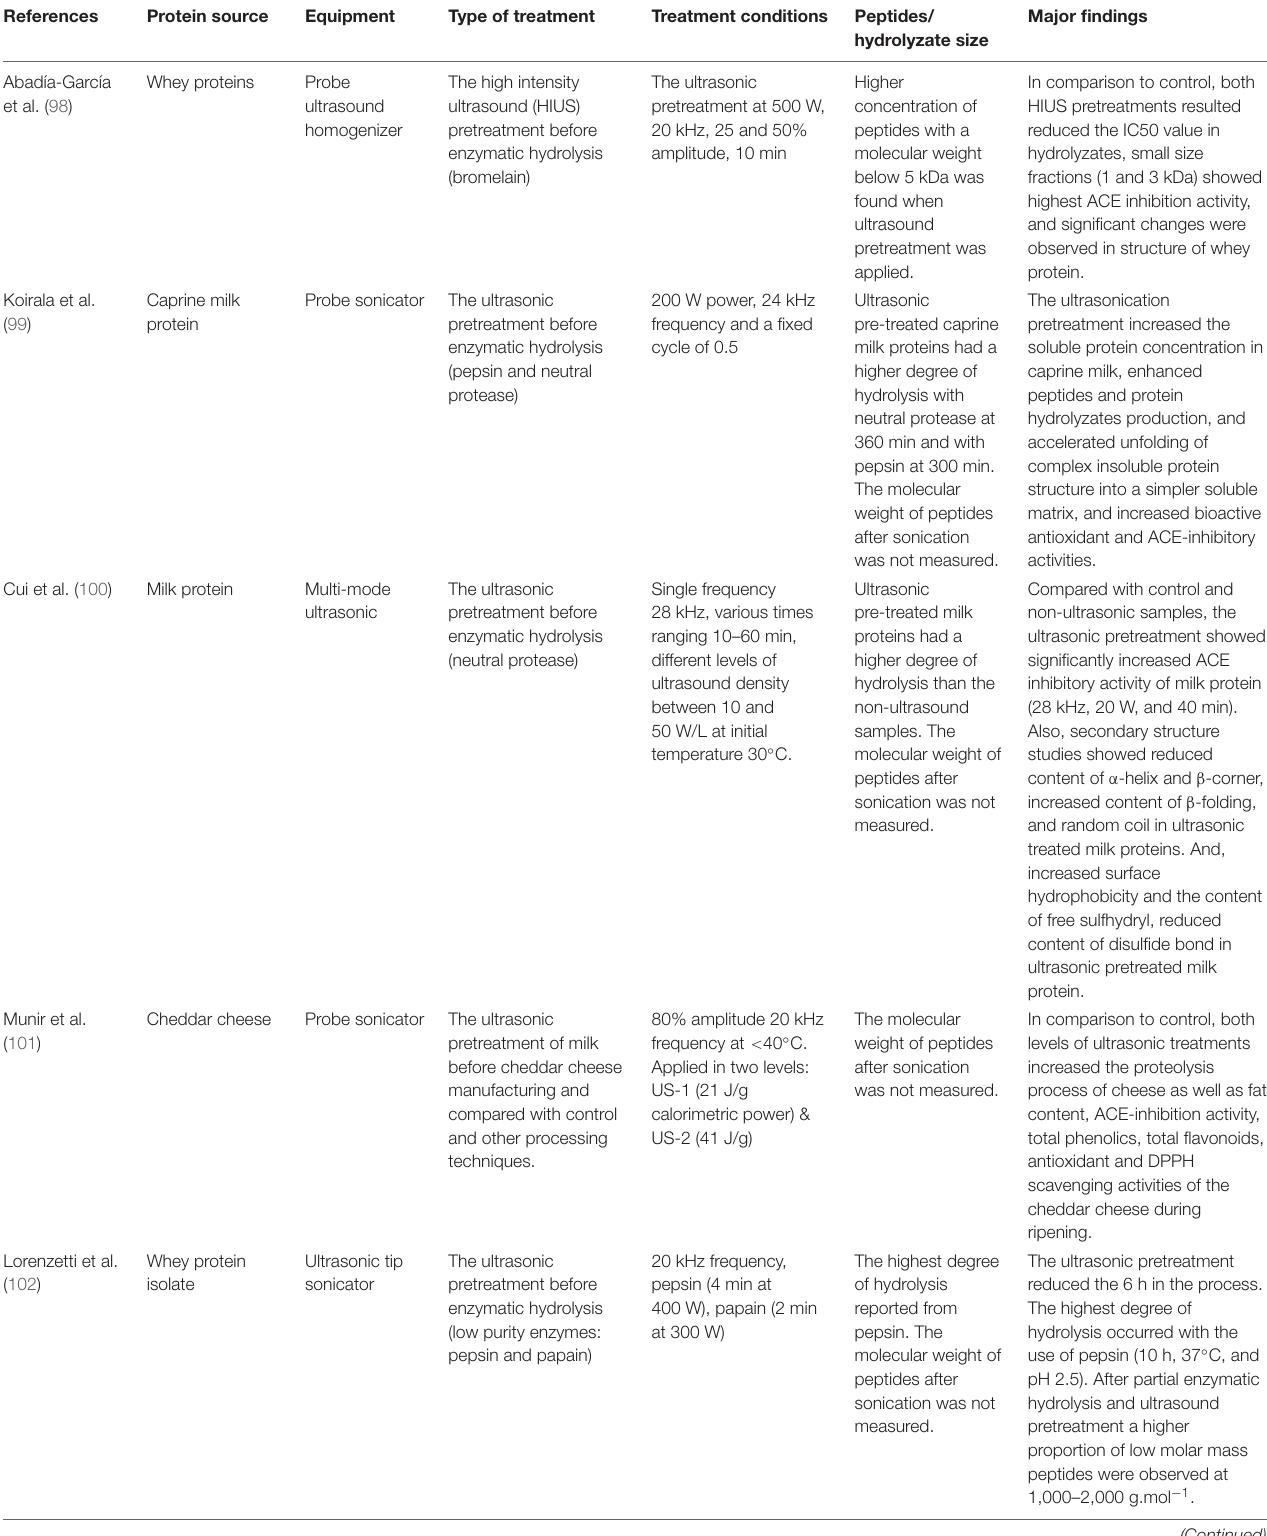
TABLE 3 | Applications of ultrasound- assisted processing for the production of bioactive